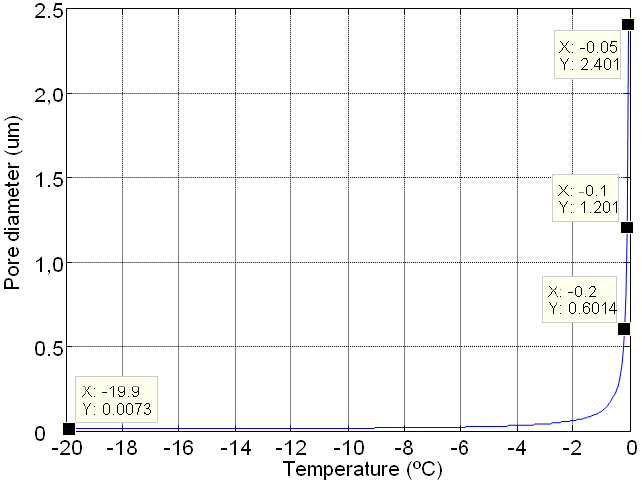
Figure 1. Numerical study of the theoretical behaviour of the pore diameter versus